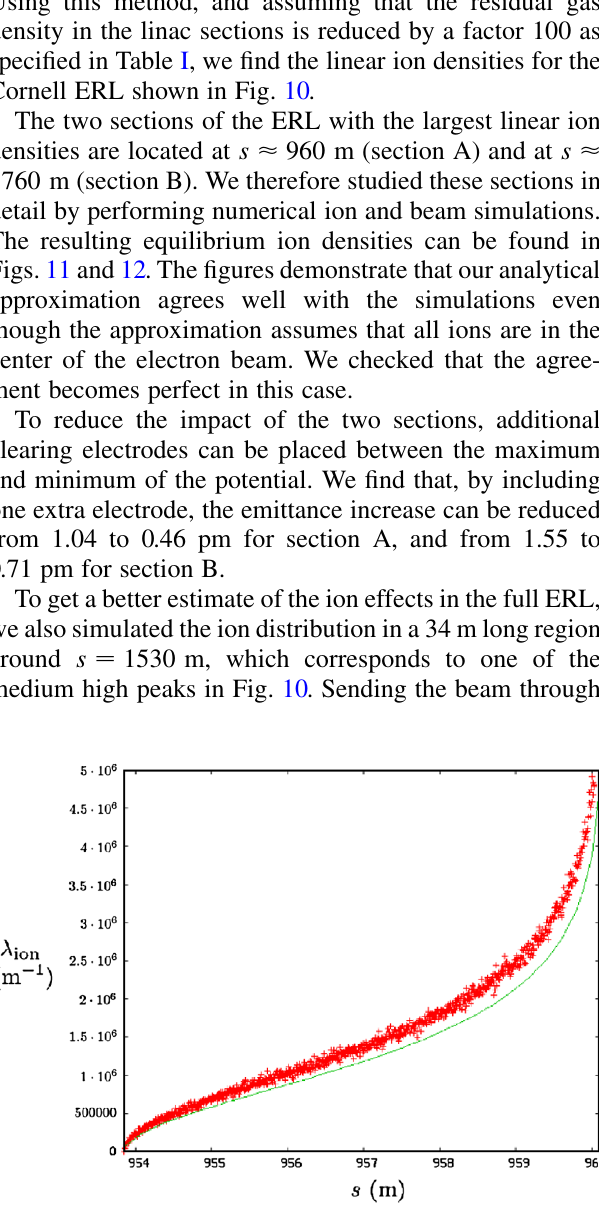
FIG. 11. (Color) Simulated and analytically approximated linear ion densities near s (cid:5) 960 m in the Cornell ERL.